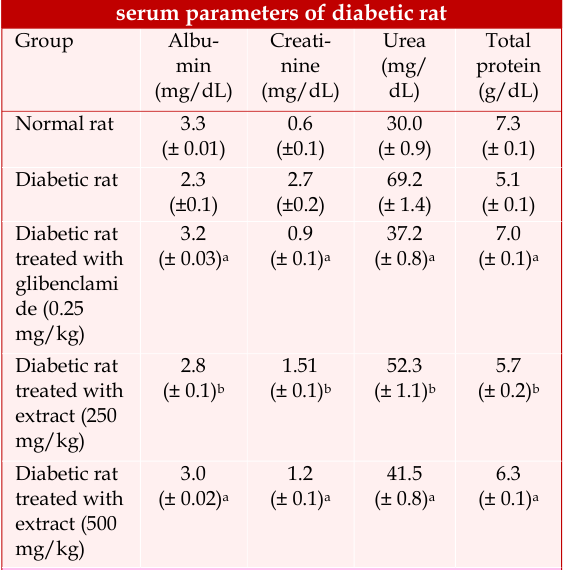
Effect of the aqueous extract of S. sesban leaves